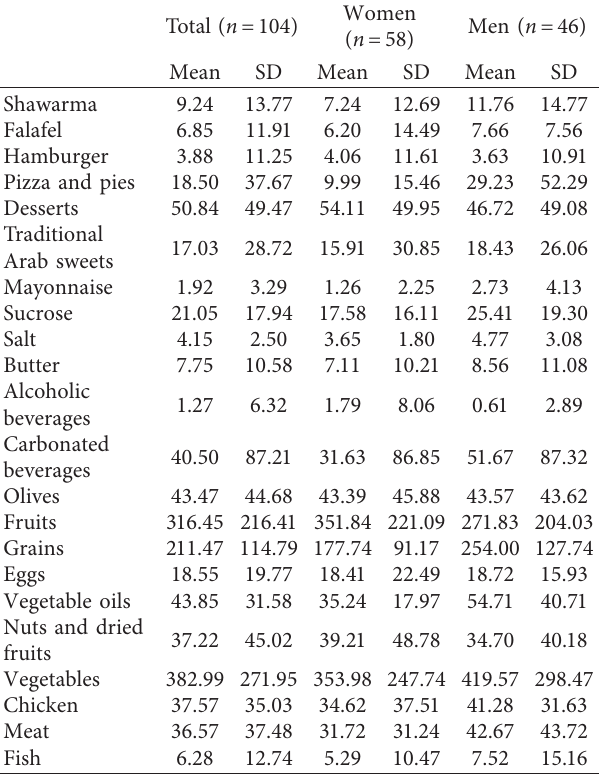
Table 3: Food intake of the study